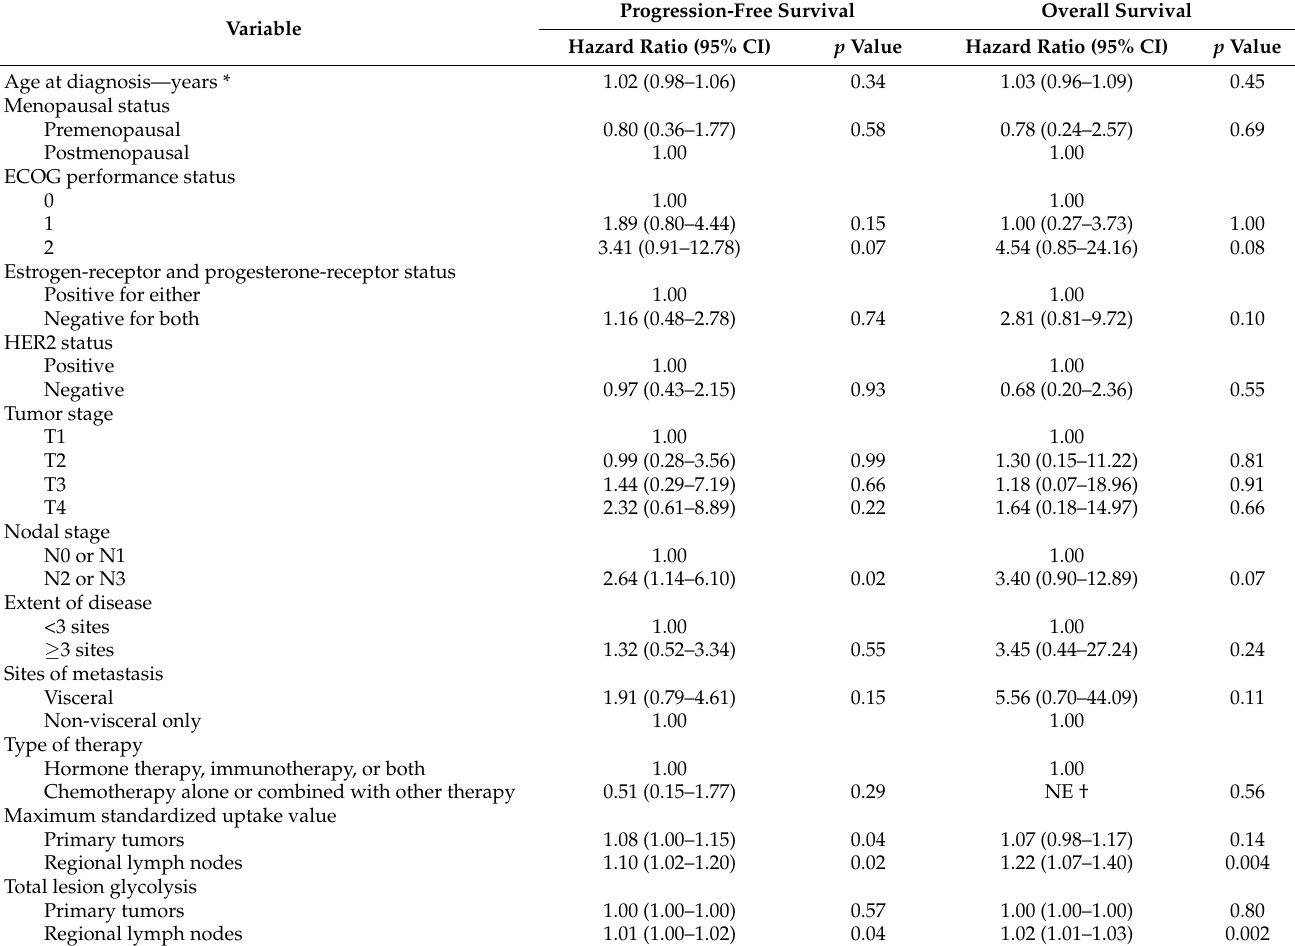
Table 2. Univariate Cox regression models of progression-free survival and overall